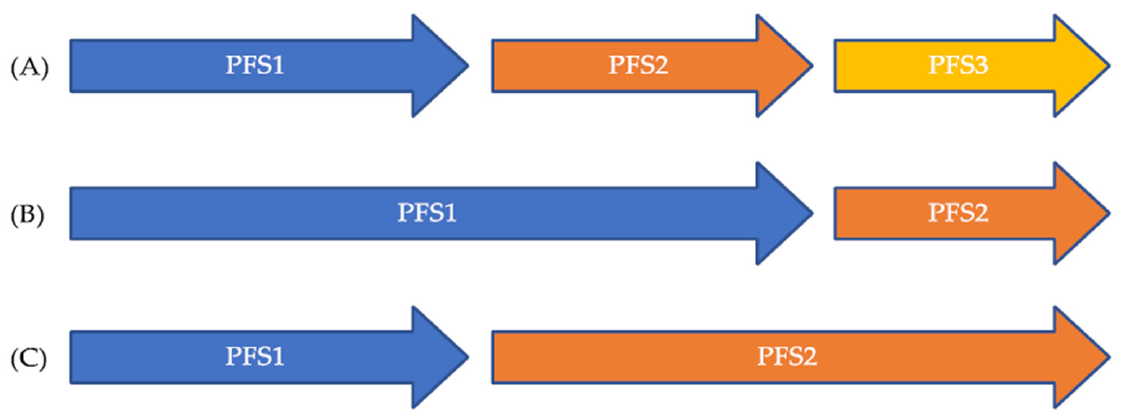
Figure 1. Illustration of the PES ration. ( A ) Expected natural history of cancer in the recurrent and/or metastatic setting with decreasing efficacy of treatments over time; ( B ) PES ratio < 1 suggesting a decreased efficacy of the second drug over the first; ( C ) PES ratio > 1 suggesting a benefit from the new treatment over the first.